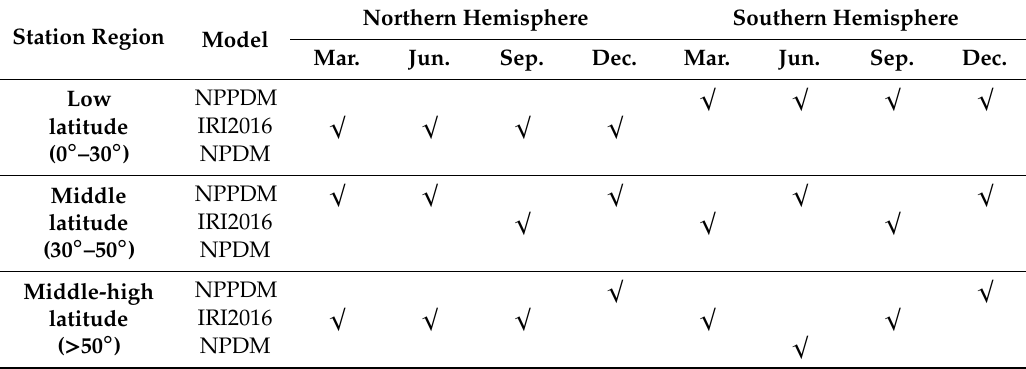
Table 4. Same as Table 3, but for high solar activity.